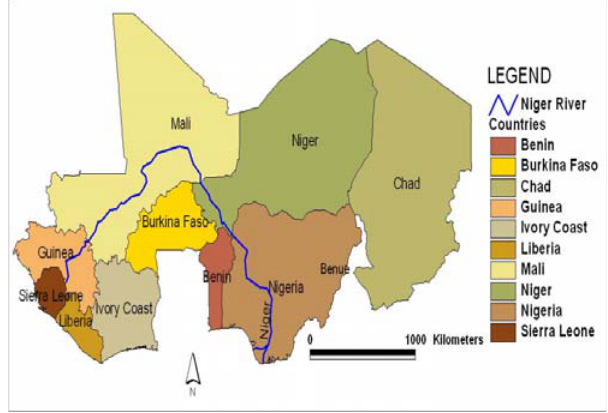
Figure 1.2: Map of the entire Niger River region These are two landlocked nations in West Africa located along the border between the Sahara and Sub- Saharan regions in an area stretching over 2,506,700 km² with a combined population of 32.7 million. The population distribution for each country shows Niger with about 12.2 million people and Mali 10.5 million. The geographic coordinates for Niger are a longitude of 16°N and latitude of 8°E while Mali is located southwest of Algeria along the geographic coordinates of 17°0'0" N 4°0'0" W. The climate of both nations is mainly hot and dry, with much area covered by desert. The major natural hazards consists of recurring droughts while